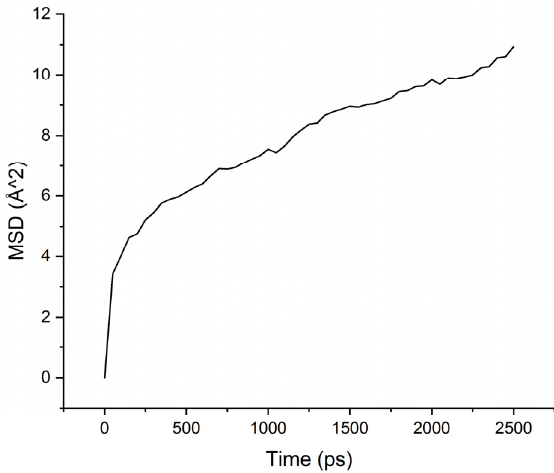
Figure 4. MSD for PAA-water system.